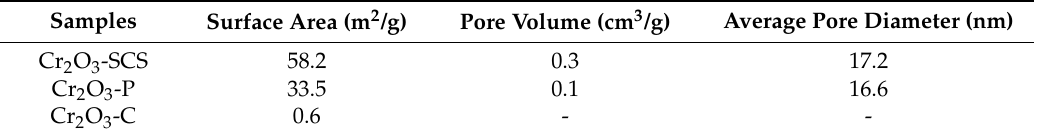
Table 2. Textural parameters of Cr 2 O 3 prepared by different